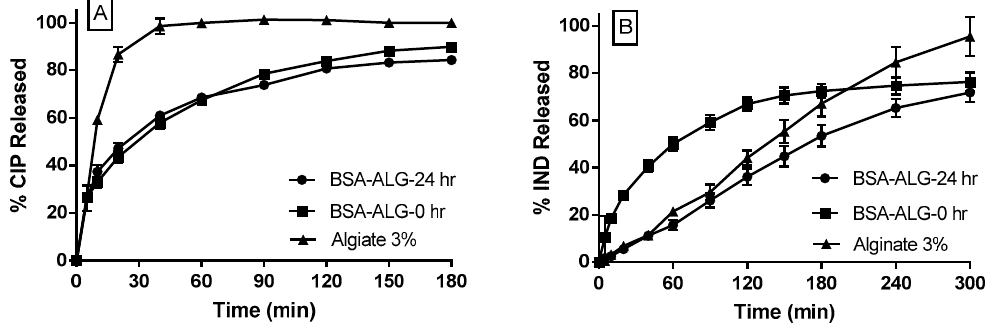
Figure 4. ( A ) Release profiles of ciprofloxacin (CIP) in SGM from ALG3%, BSA-ALG-0 h and BSA-ALG-24 h gastric beads. ( B ) Release profiles of indomethacin (IND) in simulated intestinal medium (SIM) from ALG3%, BSA-ALG-0 h and BSA-ALG-24 h intestinal beads.